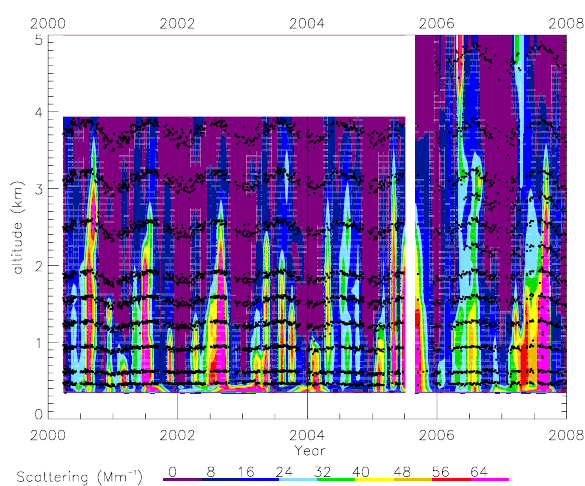
Fig. 1. Contour time series showing aerosol light scattering in terms of fractional year and altitude for the 8yr of airplane measurements. Gap in the time series around 2005.5 was during the upgrade to a new airplane and inlet. Black dots on figure indicate individual flight segments from the 597 flights flown between